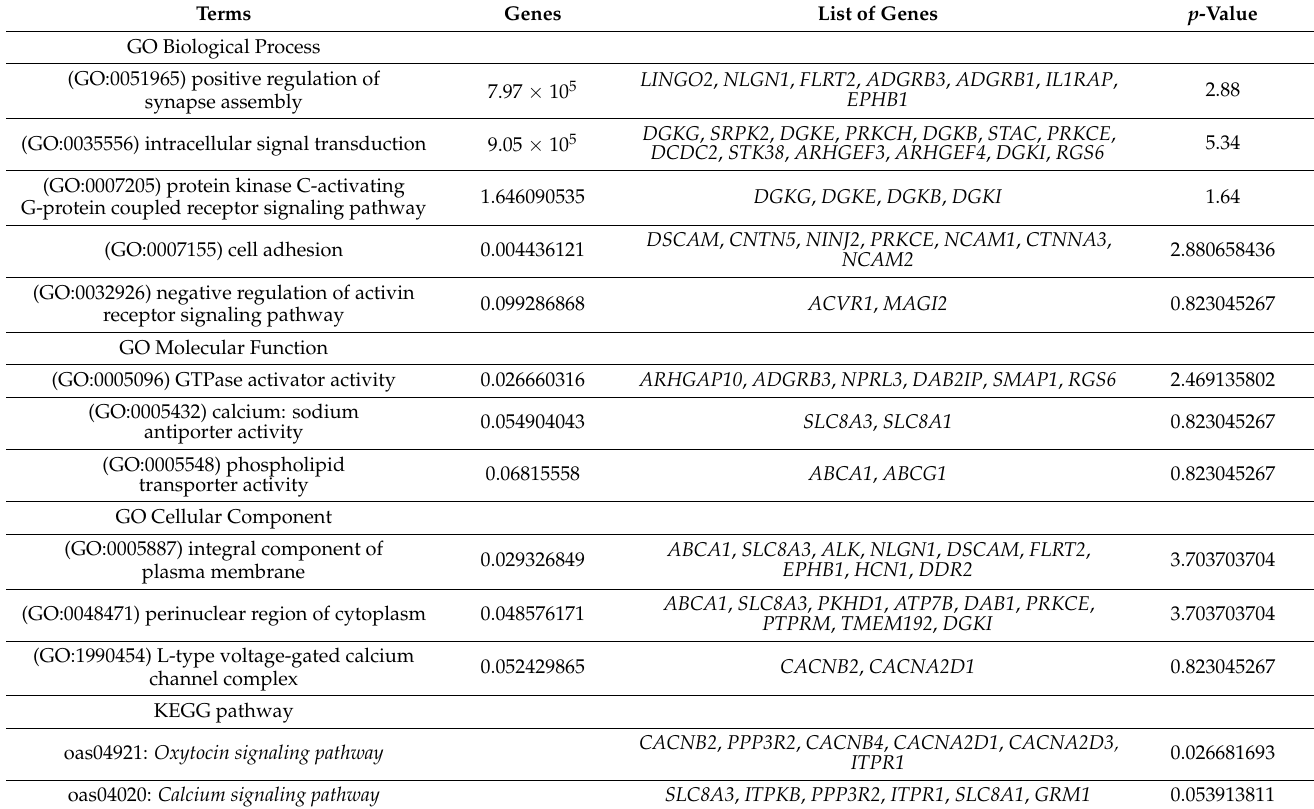
Table 6. Gene Ontology (GO) and Encyclopedia of Genes and Genomes (KEGG) pathway analysis of gene-based enrichment ( p < 0.01) in